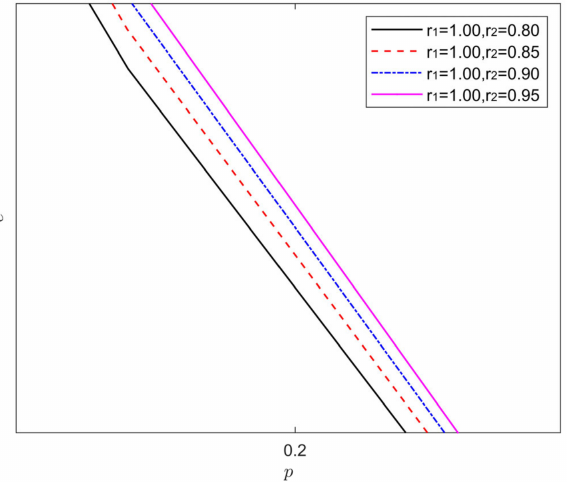
Figure 8. The development of the game’s strategy in a (rational, optimistic) condition.